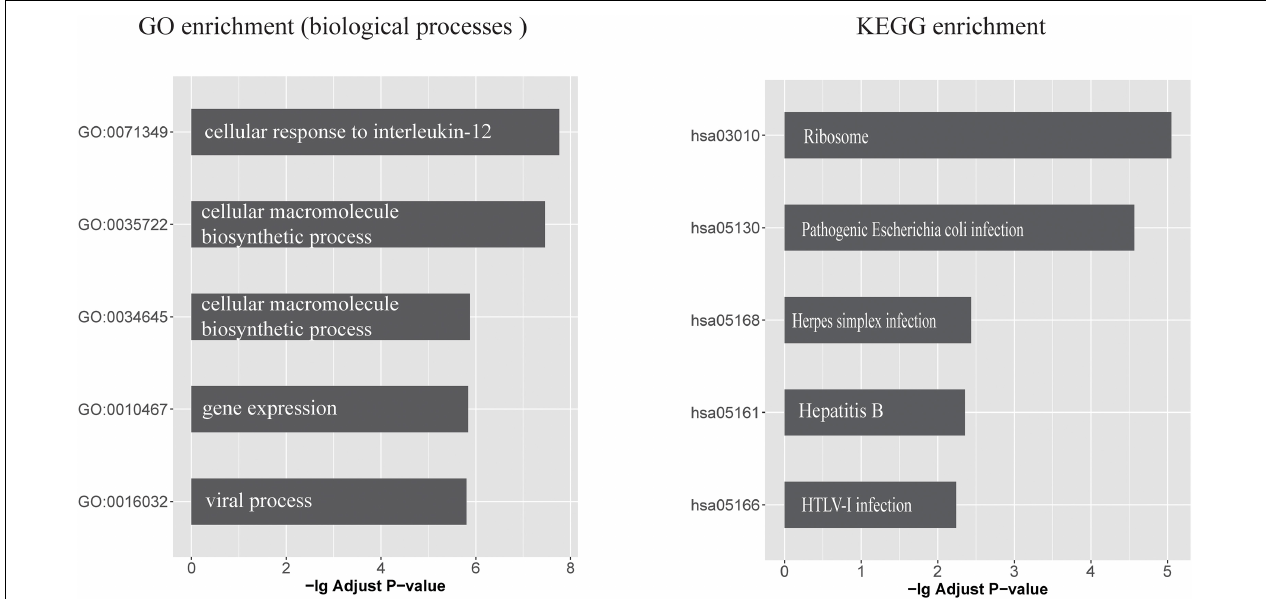
FIGURE 1 | The top five GO biological processes and KEGG pathways that enriched with circRNA-regulated mRNAs (left) GO biological processes categories and (right) KEGG pathways, which enriched with circRNA-regulated mRNAs. x-axis represents the -log10 (Adjusted P